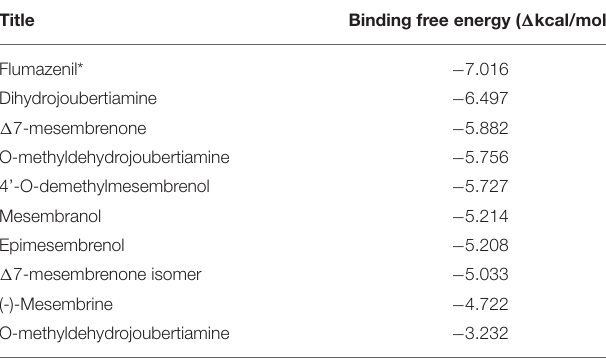
TABLE 3 | Docking scores attained from docking XP scores ( in silico ) on serotonin transporter (GABA-A).